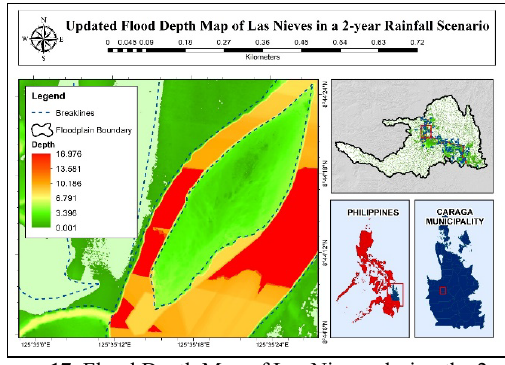
Figure 17 . Flood Depth Map of Las Nieves during the 2-year Rainfall Scenario using the Updated UAS-based DTM.